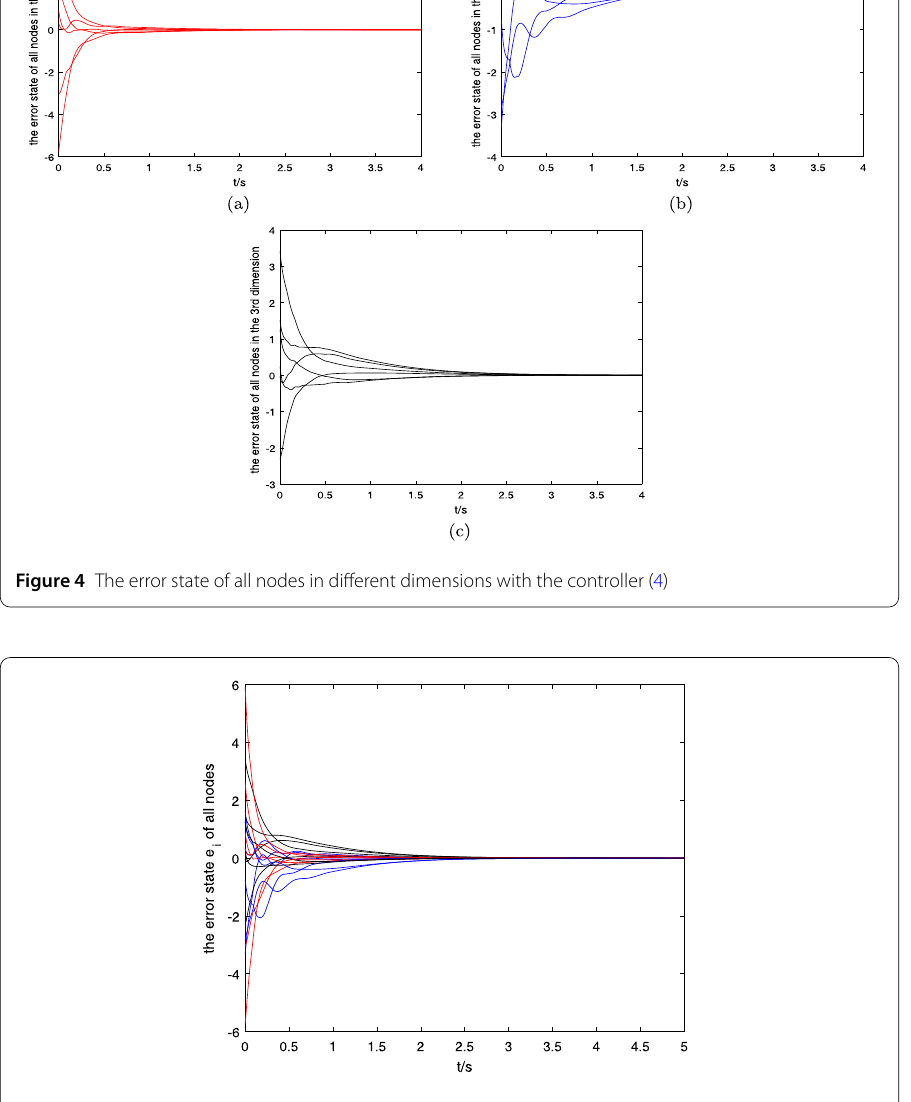
Figure 5 The error state e i of all nodes when h 1 = 3, h 2 = 3, h 3 = 4, h 4 = 5 and θ =